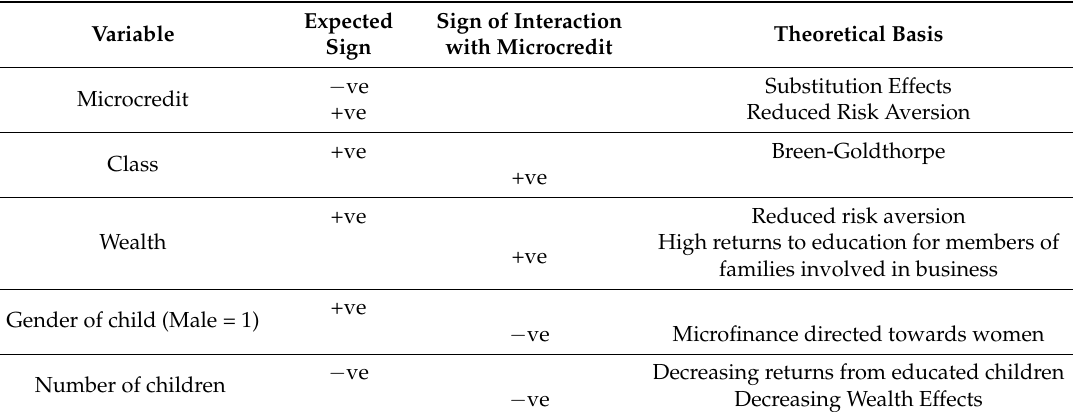
Table 1. Description of key variables and their expected effects on children’s